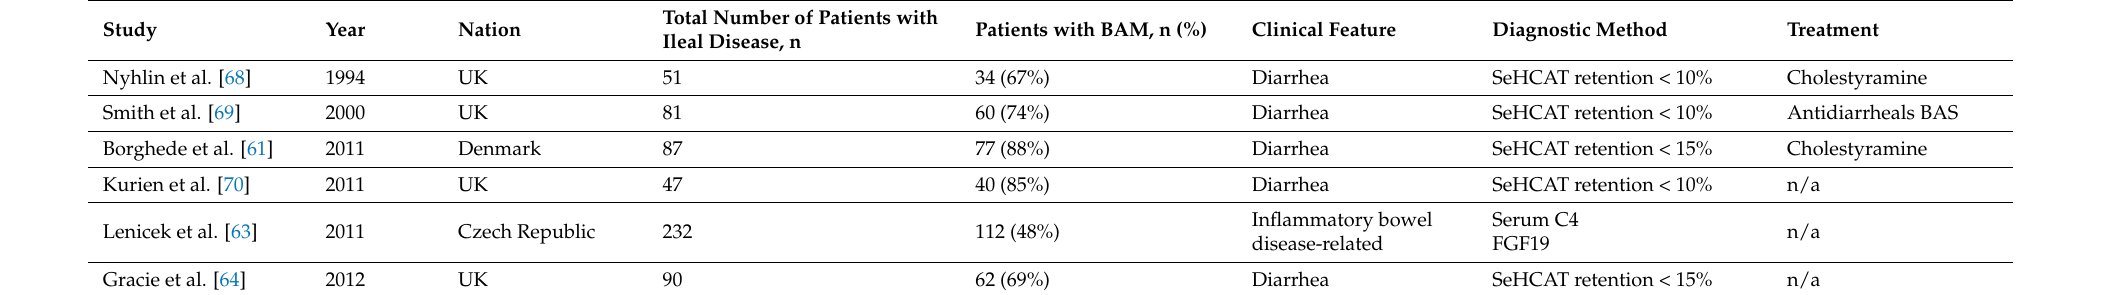
Table 1. Studies investigating the prevalence of bile acid malabsorption type